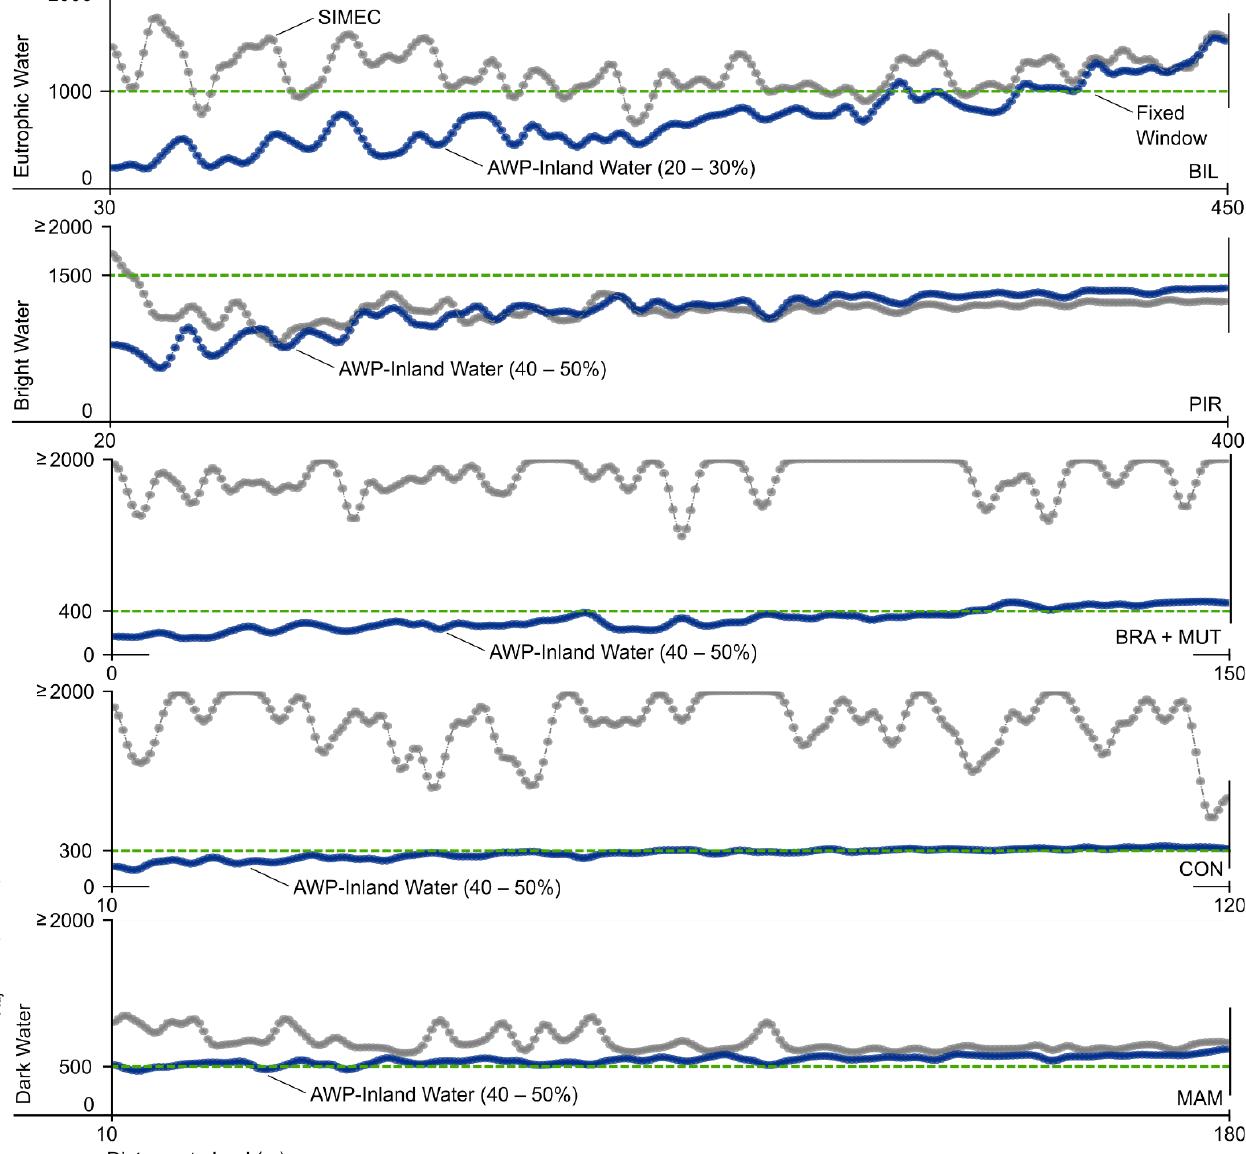
Figure 4. Differences in sizes of H Adj obtained from the fixed and adaptive window approaches for the three selected water types. The analysis was performed with N = 250 pixels per water body. The pixels were randomly selected on the water bodies considering their linear distance from the waterline. The dashed green line refers to H Adj based on the fixed window method, while the gray and blue markers refer to use of the SIMEC and AWP-Inland Water methods, respectively.